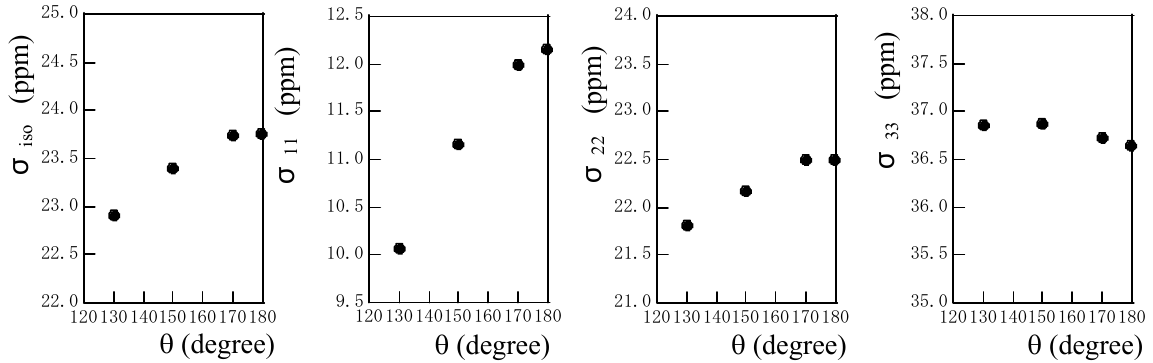
and chemical shielding iso